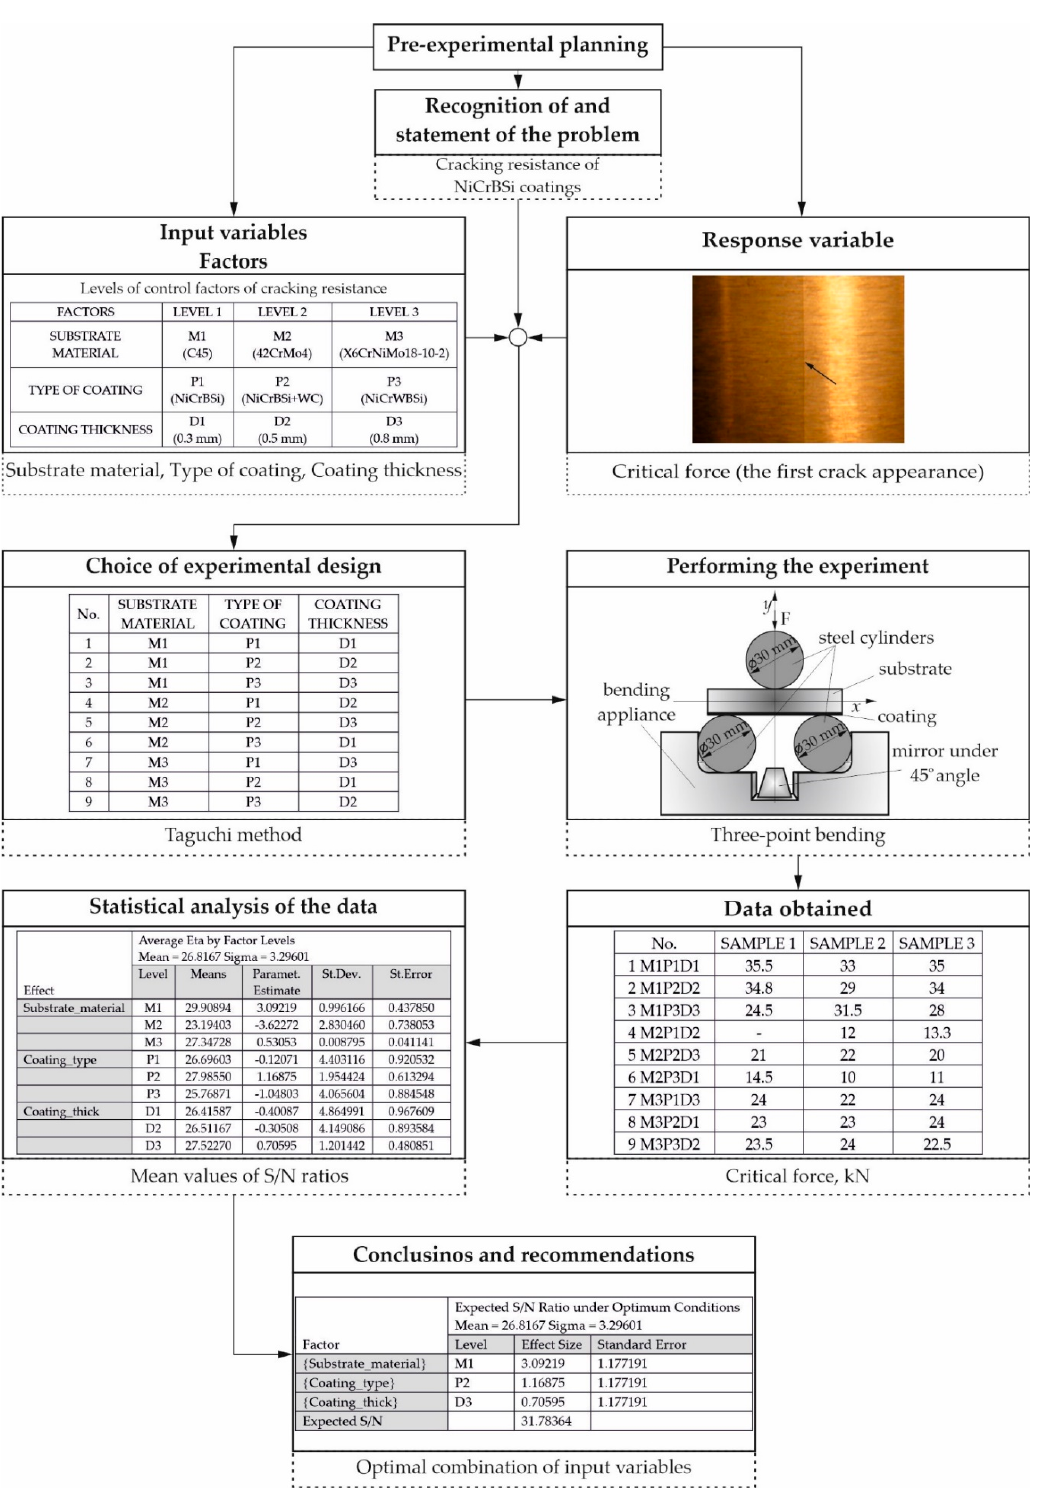
Figure 3. Adhering to the guidelines for designing the experiment [8].